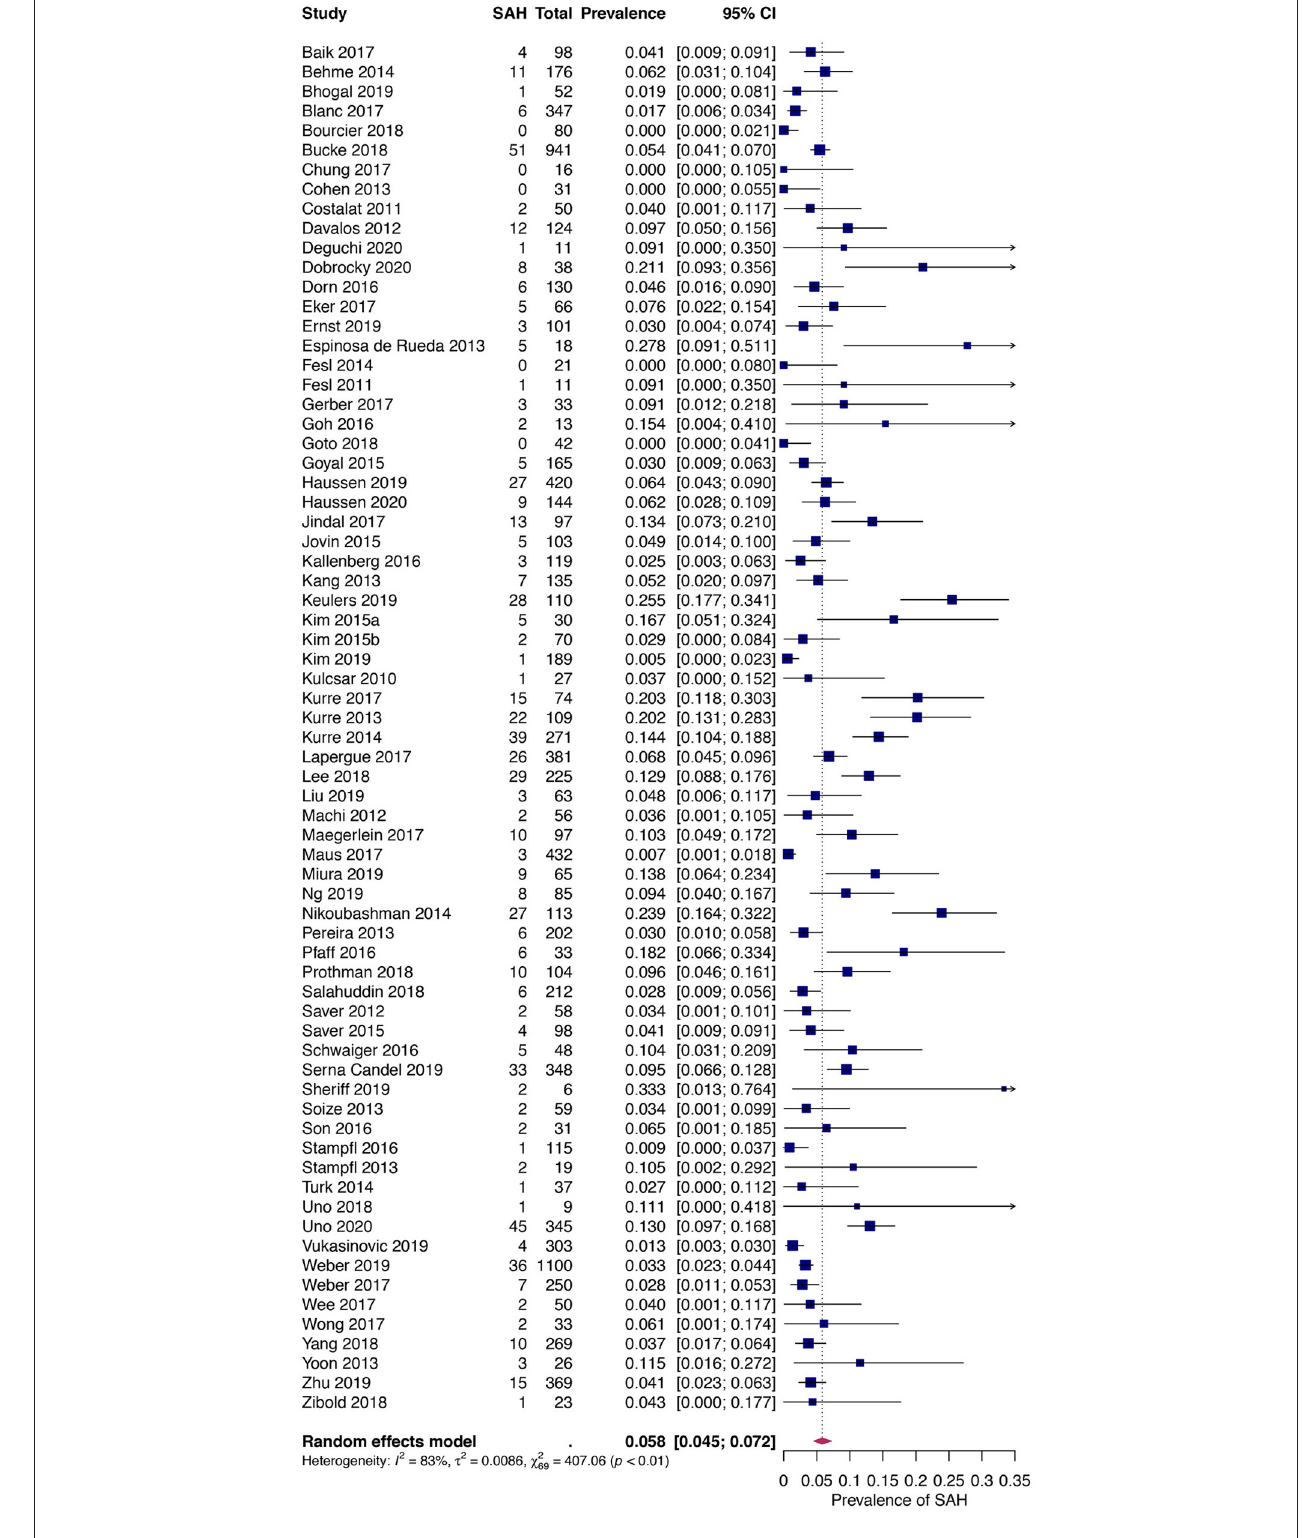
FIGURE 2 | Pooled prevalence of subarachnoid hemorrhage following mechanical thrombectomy.